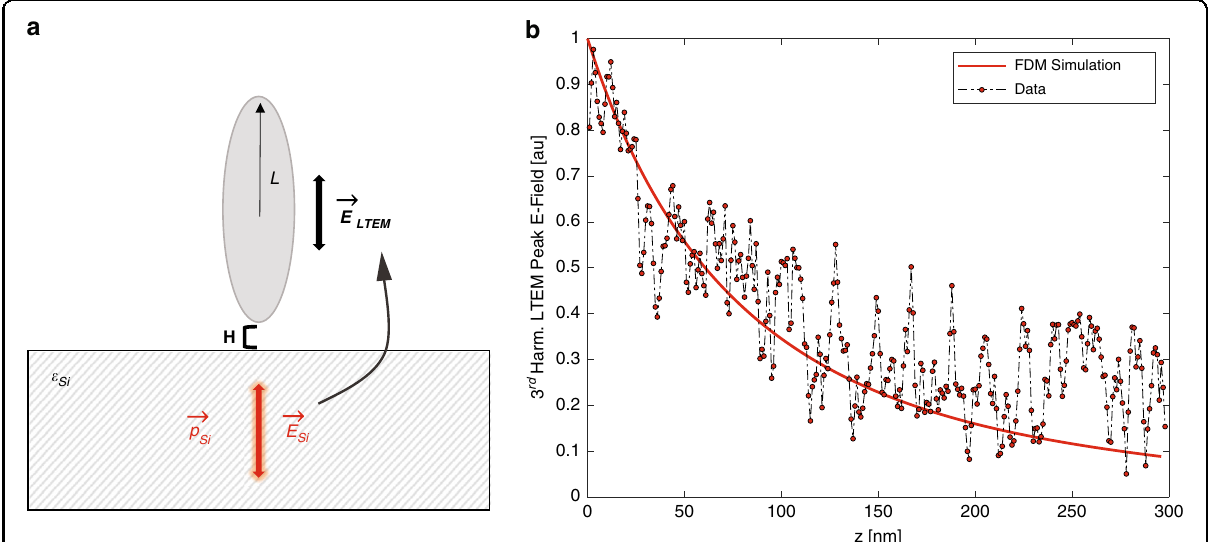
Fig. 5 The LTEM Finite Dipole Model. a Schematic of the LTEM FDM. The tip (represented as a spheroid of half-length L) is held above a sample with dielectric function ε Si . A subsurface dipole ~ p Si generates a subsurface fi eld ~ E Si , which leaks out of the substrate and is felt by the tip as effective fi eld ~ E LTEM . b Successful parameter tuning of the LTEM FDM (solid line) to a 4th harmonic NIR-induced THz emission approach curve on p-InAs (circular